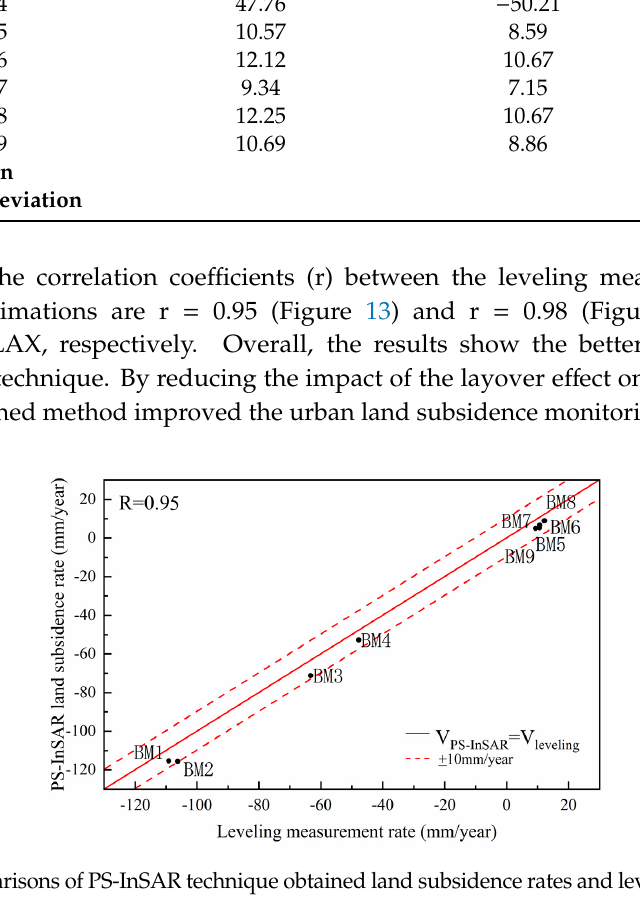
Figure 14. Comparisons of PS-InSAR+RELAX obtained land subsidence rates and leveling measurement rates from 2014 to 2016. The location of benchmarks is marked as “BM1-BM9” (see Figure 2). 5. Discussion As the side-looking geometry of SAR causes the feature displacement and layover effect that depends on the height of the features, SAR image interpretation is particularly challenging over dense urban areas with high-rise buildings [36]. The layover scatterers do not have amplitude stability and spatial coherence, and as such they hinder PS identification, which is a critical processing step for the monitoring of land subsidence. To overcome these limitations, commonly observed within the PS-InSAR technique, it is necessary to improve the process of PS identification. In this study, we have demonstrated that the proposed spectral analysis method called RELAX is advantageous over some other spectral analysis methods, such as the BF and SVD tomography imaging methods, in identifying single and layover scatterers. For that reason, the integrated PS-InSAR+RELAX technique is advantageous over the PS-InSAR technique in identifying PSs, and consequently, in monitoring land subsidence. The results demonstrate the better capability of